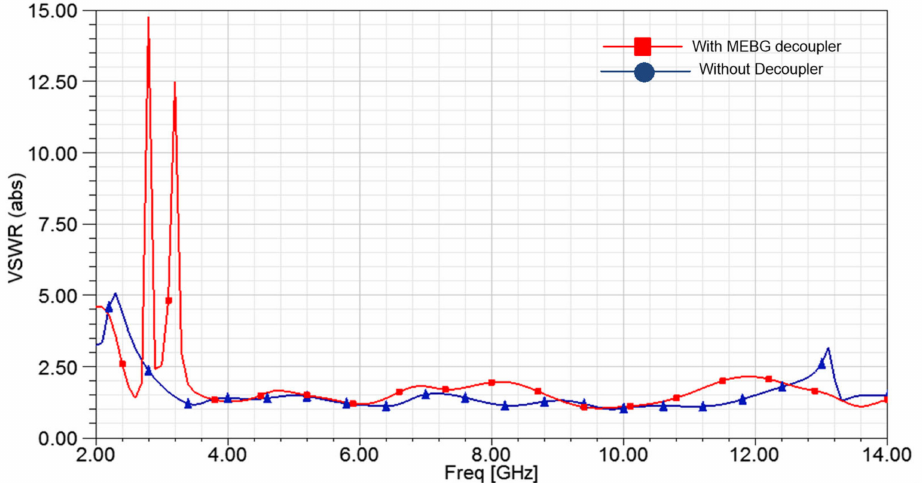
Figure 9. Antenna VSWR with and without MBEG decoupling